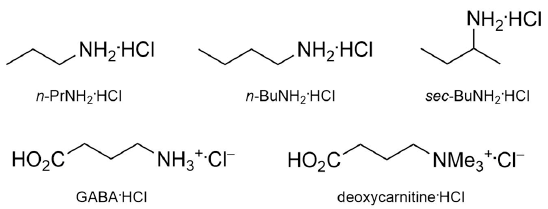
Figure 5. Structures of the ammonium hydrochloride guests studied.